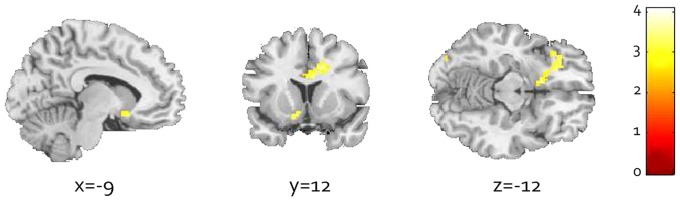
Cue-reactivity in AD patients compared with both comparison groups (D/A patients and HC).Two clusters are visible: Activation of a large cluster reaching from the OFC to the VS, and in the ACC. Colored bar: Z-scores from 0 to 4, P<0.005, clustersize threshold > = 15 voxels.